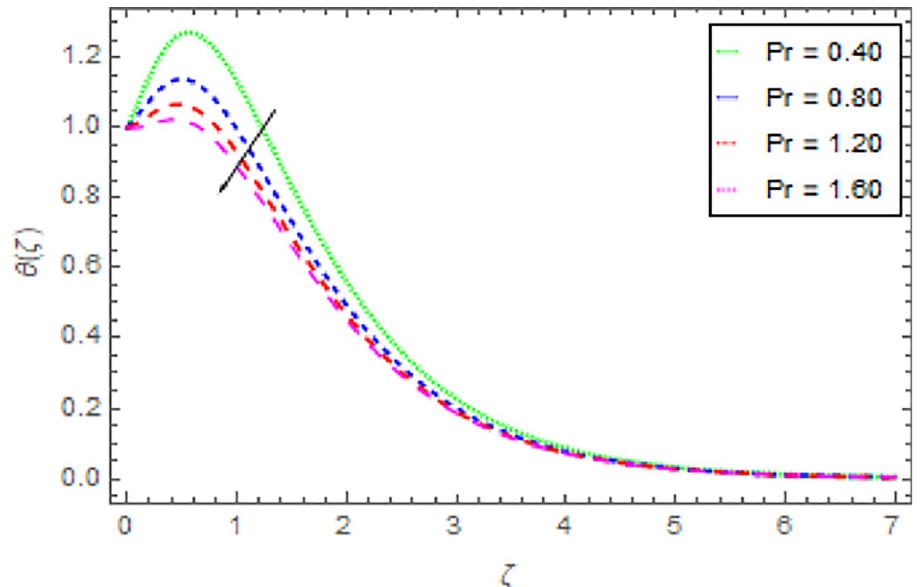
Fig 12. Deviation in nanofluid temperature against Pr when m = 0.10, n = 1.00, M = 2.50, δ = 0.40, β = 1.00, Nr = 0.20 and ϕ = 0.01 to ϕ = 0.04.